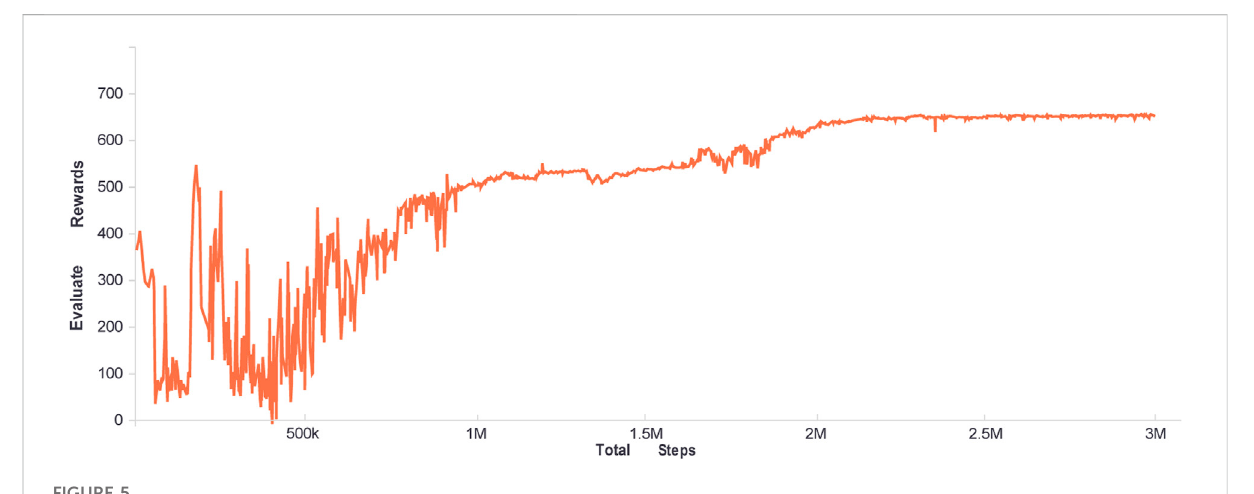
FIGURE 5 The average rewards of every evaluation.